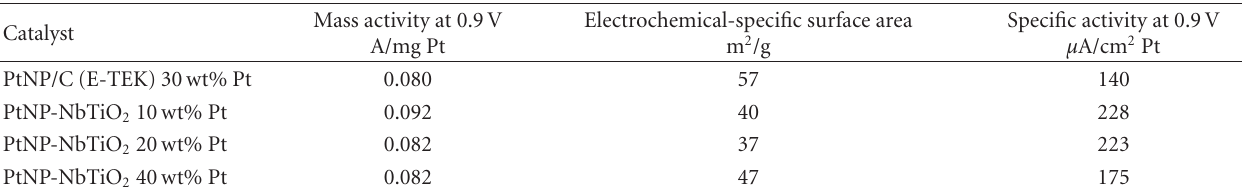
Table 1: Comparison of mass and specific activities for ORR and Pt electrochemical surface area of the di ff erent catalysts. All these three Pt NP/TiO 2 catalysts show better mass and specific activity than those of the state-of-the-art commercial Pt/C catalyst.